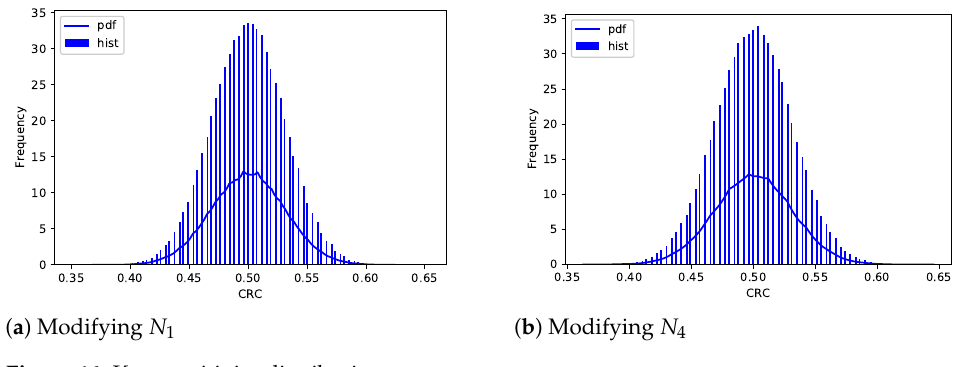
Figure 16. Key sensitivity distribution. Modifying N